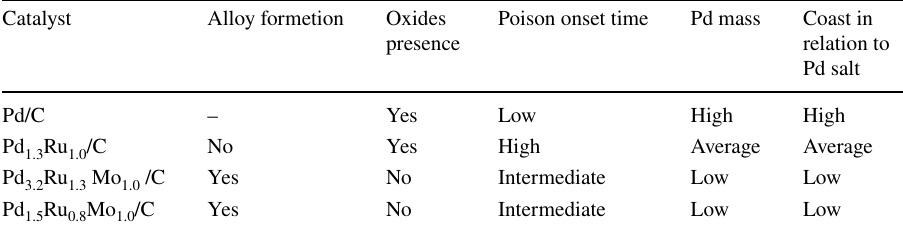
Table 6 Brief summary of the main characteristics and differences between